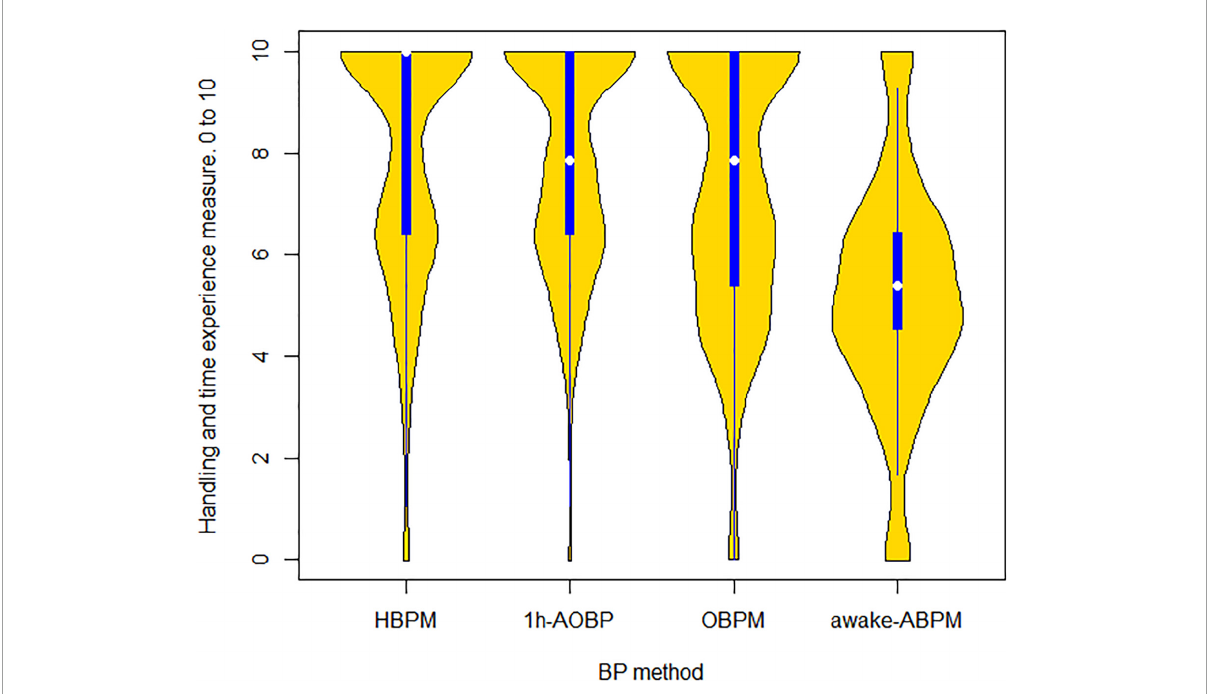
FIGURE1 Distribution plot with the experience (0–10 scale) by BP method. The yellow shape shows density of the data at different values of patient experience, and the blue line and white dot are the inter-quartile rank and median,